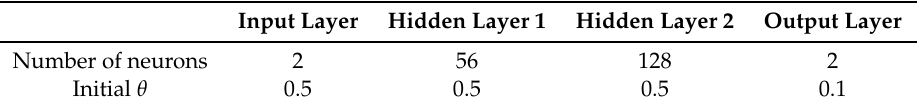
Table 3. Architecture of DQN.